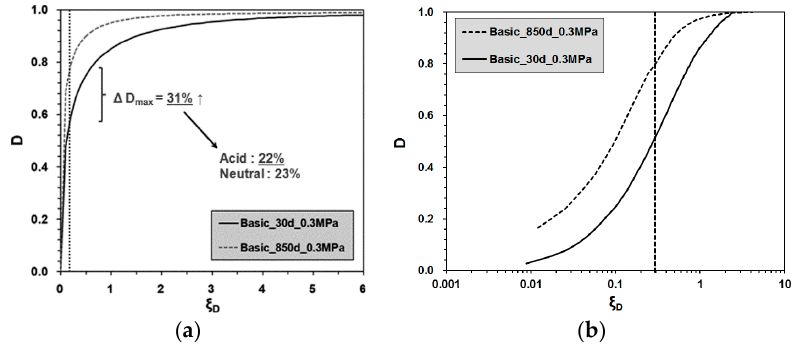
Figure 11. Maximum decreases of the disturbance ( Δ D max ) under 0.3 MPa: ( a ) natural scale for strain axis; ( b ) log scale for strain axis. Table 4. Maximum variations of the disturbance curves.